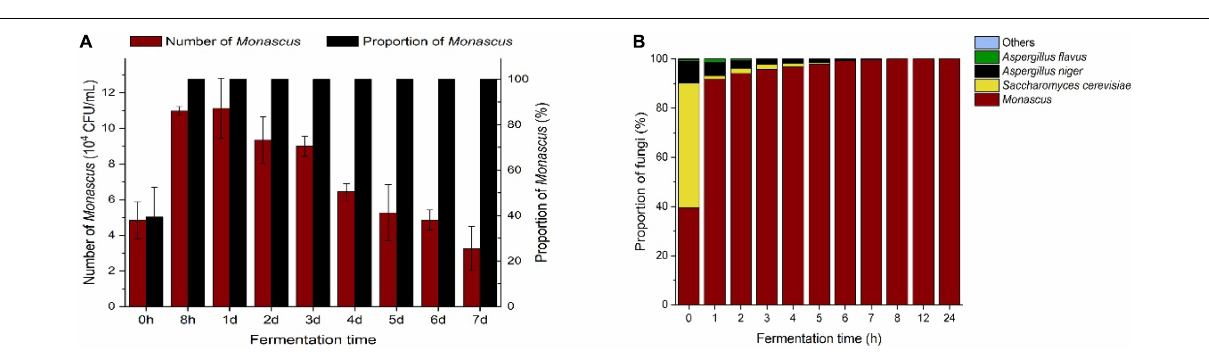
FIGURE 4 | Trends of Monascus and other culturable dominant fungi in the optimized restrictive medium supplemented with Hongqu BHQ33 during the fermentation process. Hongqu BHQ33 was added to the optimized restrictive medium containing 3.98% (v/v) lactic acid and 6.24%(v/v) ethanol for fermentation at 30 ◦ C and 200 r/min for 7 days, the number of Monascus and its proportion over time (A) and proportion of culturable dominant fungi over time (B) were calculated after the fermentation broth was diluted and spread on the modified PDA medium to culture for 4 days at 30 ◦ C. Error bars indicate the standard deviation (SD) of the means ( n =